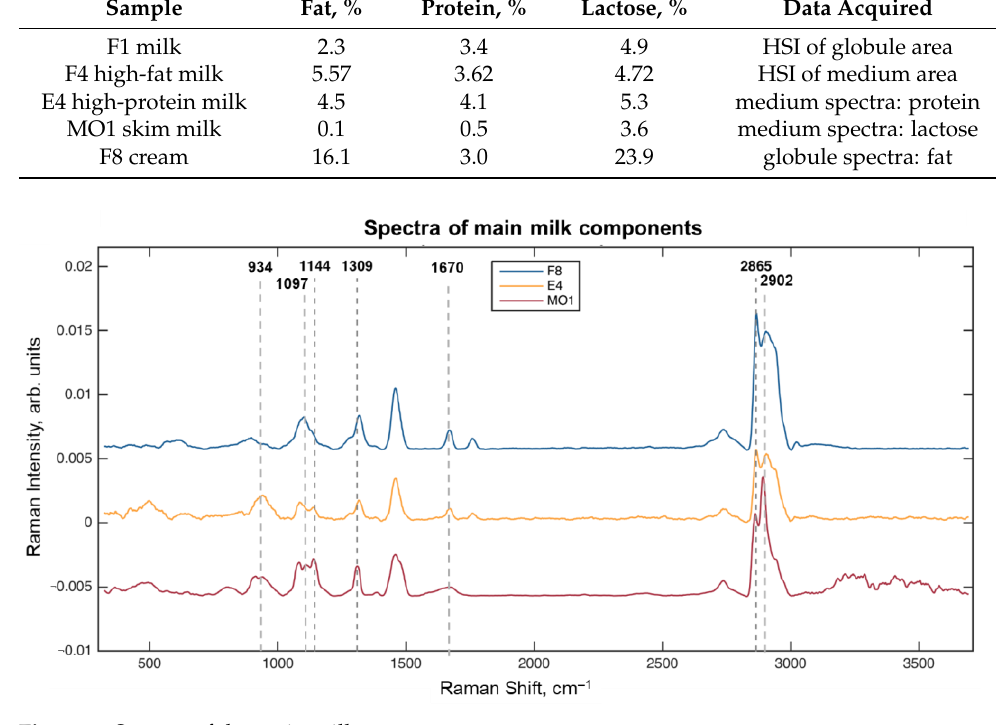
Figure 1. Spectra of the main milk components.